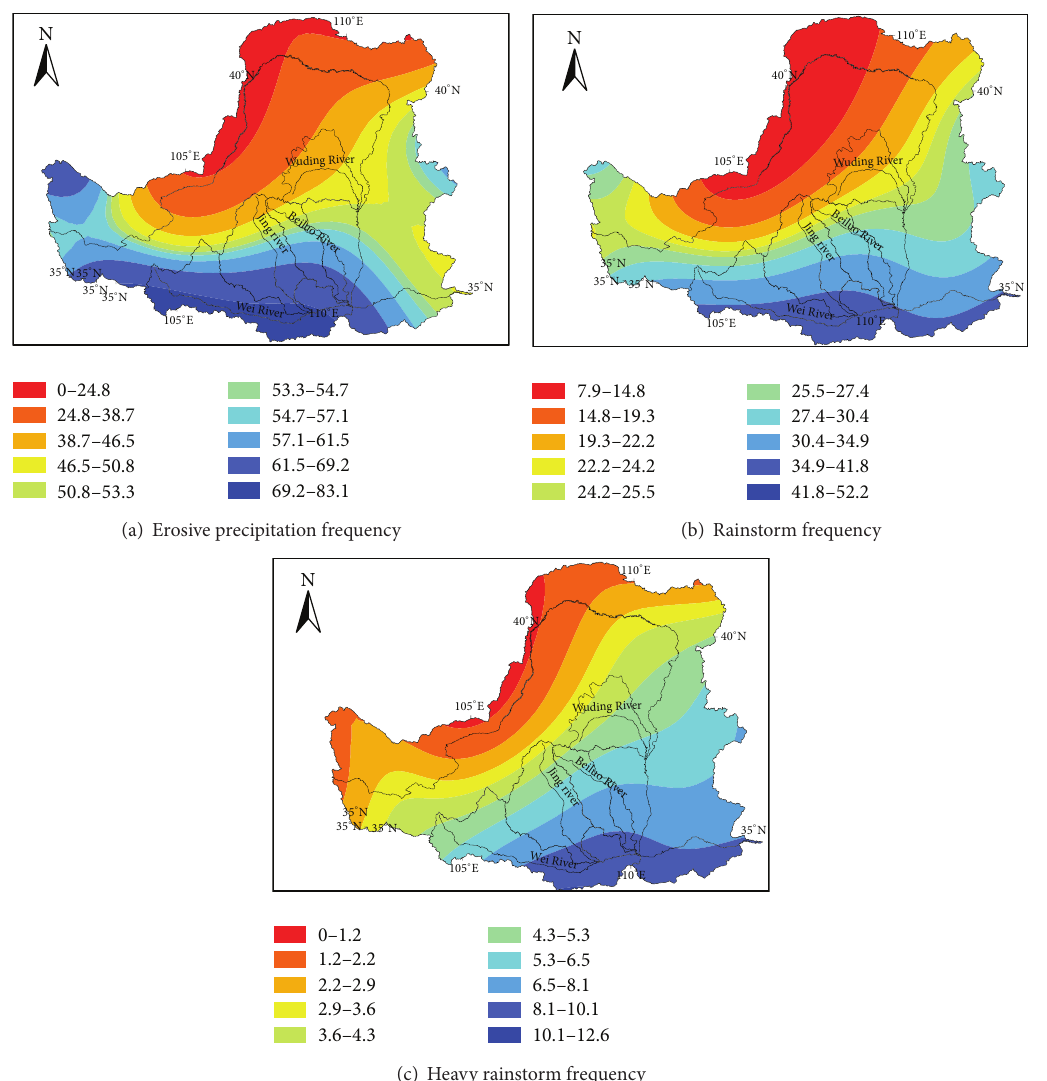
Figure 4: Frequency of different rainfall types ((a) erosive precipitation, (b) rainstorm, and (c) heavy rainstorm).